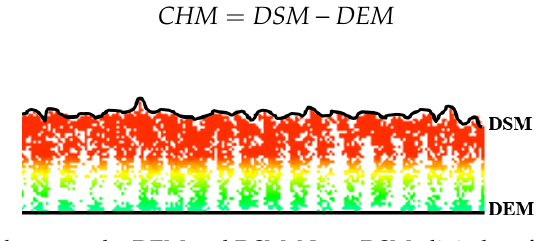
Figure 6. Relationship between the DEM and DSM. Note: DSM: digital surface model; DEM: digital elevation model.